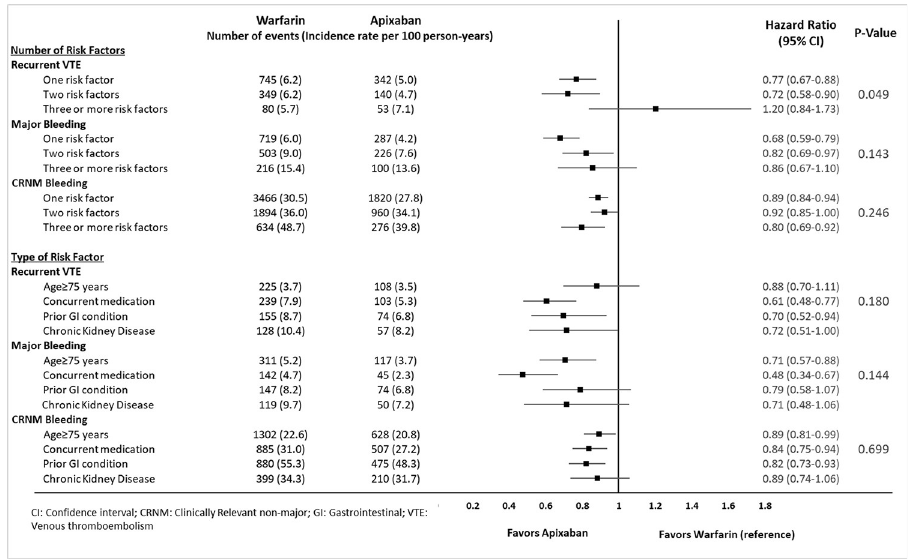
Fig 3. Risk of recurrent VTE, major bleeding, and CRNM bleeding for apixaban vs. warfarin among VTE patients at a high risk of bleeding stratified by number of risk factors and type of risk factors.